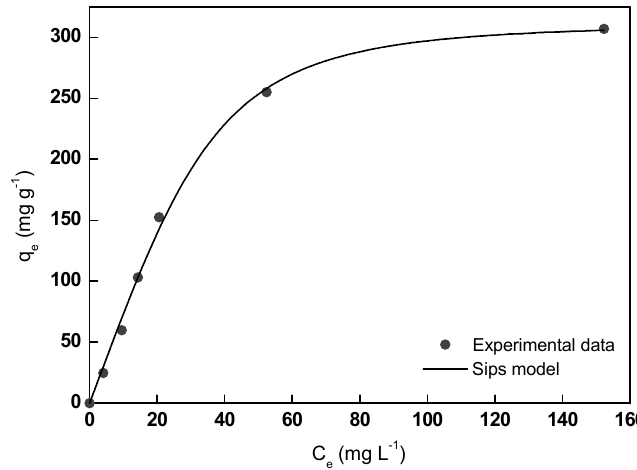
Figure 8. Experimental and theoretical MB adsorption isotherms onto A / γ -Fe 2 O 3 / f-CNT beads. Table 2. MB adsorption isotherm parameters onto A / γ -Fe 2 O 3 / f-CNT beads at room temperature.